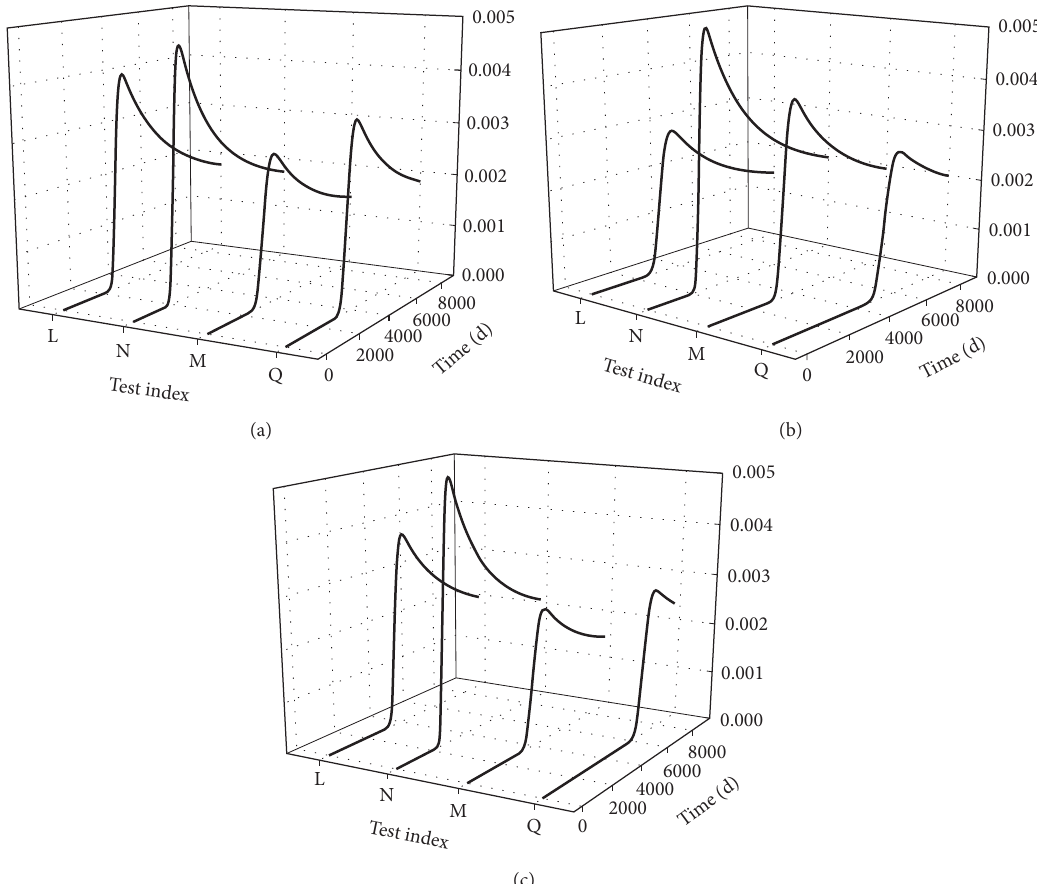
Figure 8: Density curve of different concrete. (a) C30 concrete. (b) C40 concrete. (c) C50